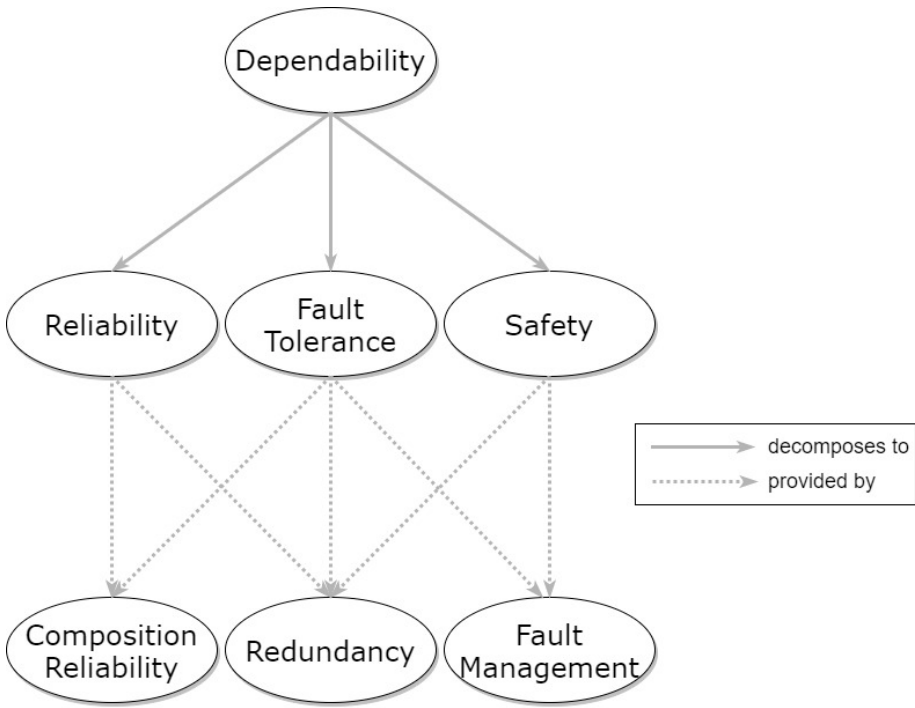
Figure 26. Hierarchical graph of Dependability properties and relevant patterns.